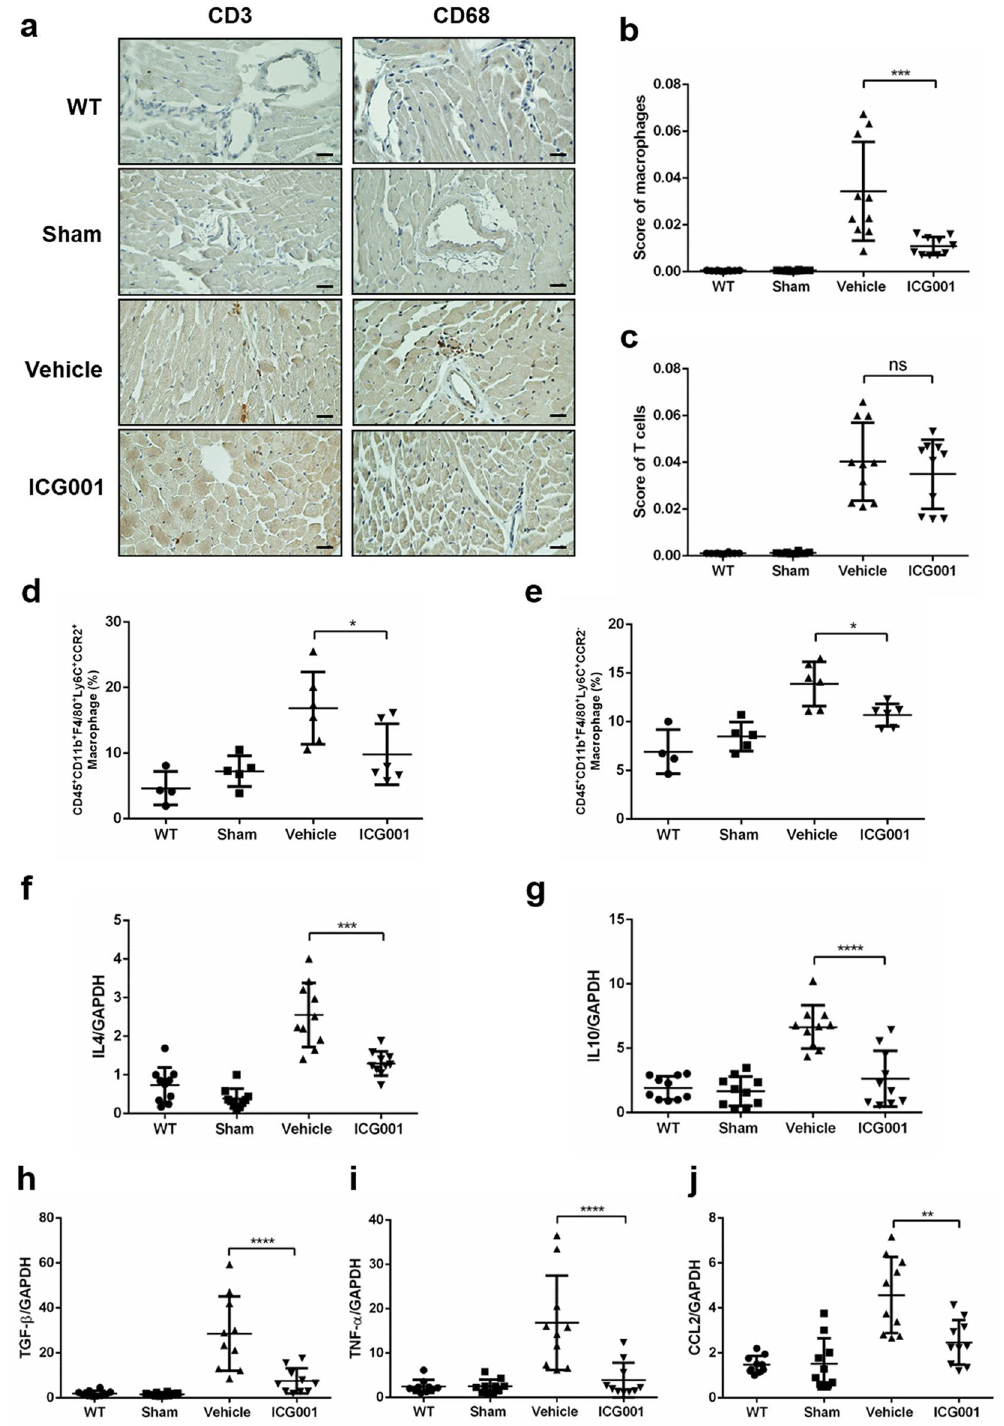
Figure 4. ICG001 attenuated macrophage accumulation in cardiac tissues after TAC. ( a ) Immunohistochemical analysis of CD3 and CD68 in heart sections (n = 10, Scale bar = 200 µm). ( b , c ) Score of macrophages detected by CD68 and T cells detected by CD3 in immunohistochemical analysis calculated by ImageJ 61 (ImageJ version 1.53e) (n = 10). ( d , e ) Flow cytometry analysis of the macrophages CD45 + CD11b + F4/80 + Ly6C + CCR2 + and CD45 + CD11b + F4/80 + Ly6C + CCR2 − in mice at 4 weeks after TAC (n = 4–6). ( f – j ) Quantitative real-time polymerase chain reaction of Il4 , Il10 , Tgfb1 , Tnfa , and Ccl2 in the heart at 4 weeks after TAC (n = 10). Statistical significance of distributed data was analyzed by one-way ANOVA followed by Tukey’s multiple comparisons test. ns not significant, **** P < 0.0001, *** P < 0.001, ** P < 0.01, * P < 0.05 vs. vehicle